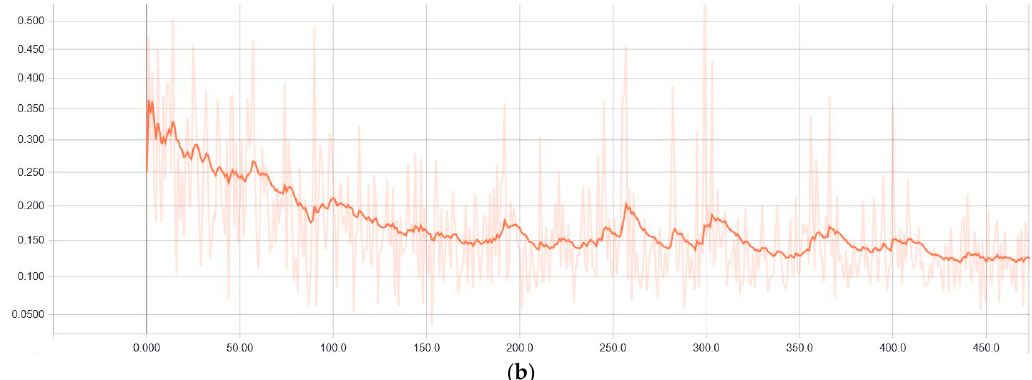
Figure 4. Loss curves (loss vs. epochs) during the ( a ) training phase and ( b ) validation phase.